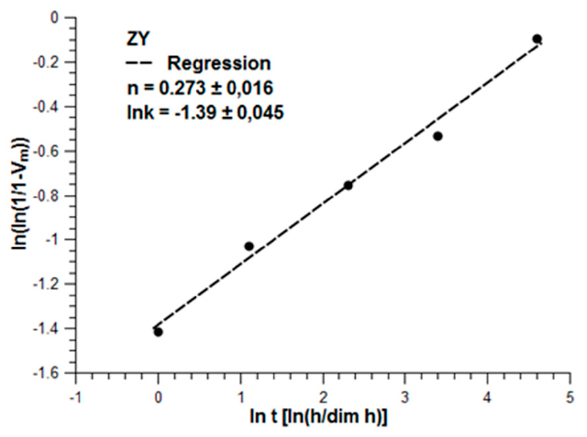
Figure 24. Increase of monoclinic phase according to Mehl-Avrami-Johnson-kinetics.